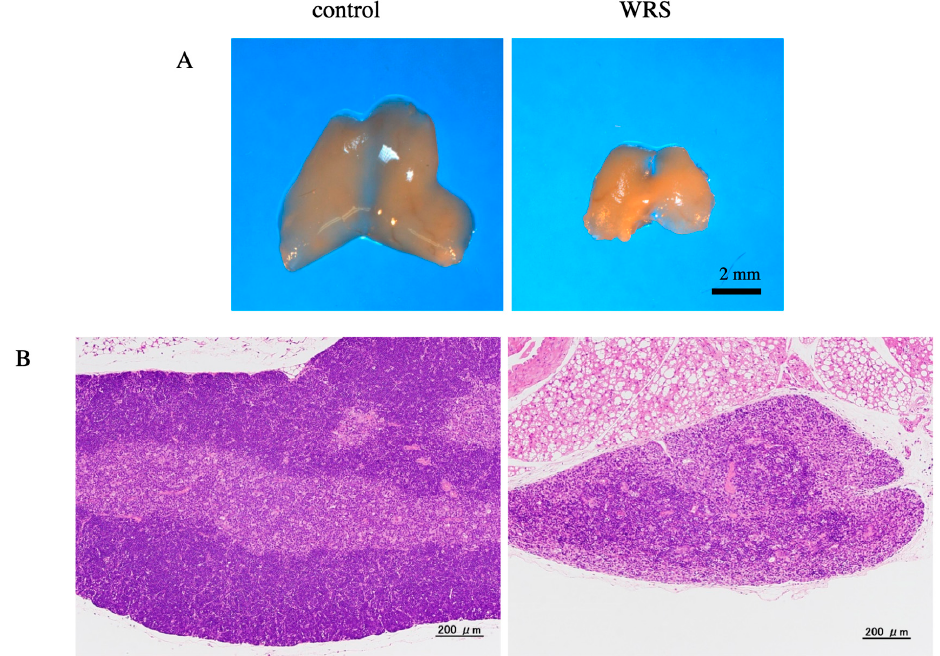
Figure 1. Morphological evaluation of the thymus. Thymus size and histological differences were compared between the control and WRS groups. ( A ) Thymus size was dramatically decreased in mice in the WRS group. ( B ) Histological analysis revealed atrophy of the thymic cortex in mice in the WRS